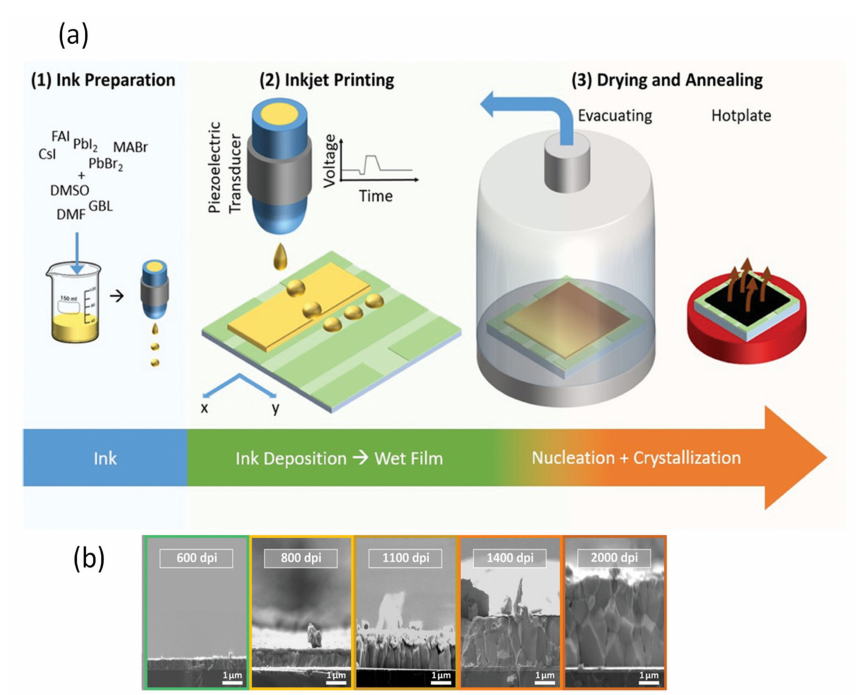
Figure 12. ( a ) Represents the important steps involved in inkjet printing of triple-cation multicrystalline perovskite (TCP) thin films: (1) ink preparation, (2) inkjet printing, (3) drying and annealing: The printed TCP wet film is transferred to a vacuum chamber to accelerate the rate of removal of the solvents to induce nucleation of the perovskite thin film. ( b ) SEM images of cross sections of PSCs with inkjet-printed perovskite films with di ff erent resolutions. Reproduced with permission from ref. [174], Copyright 2020, Advanced Energy Materials .